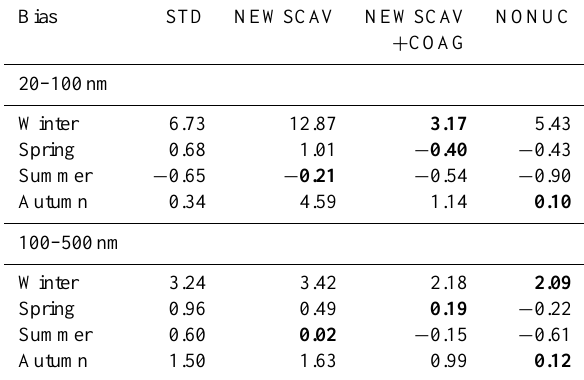
Table 3. Model–measurement fractional bias (Eq. 6) for total num- ber of aerosols with diameters of 20–100 and 100–500nm at Mt. Zeppelin (in reference to Fig. 4). Bias values closest to zero for each season are highlighted in